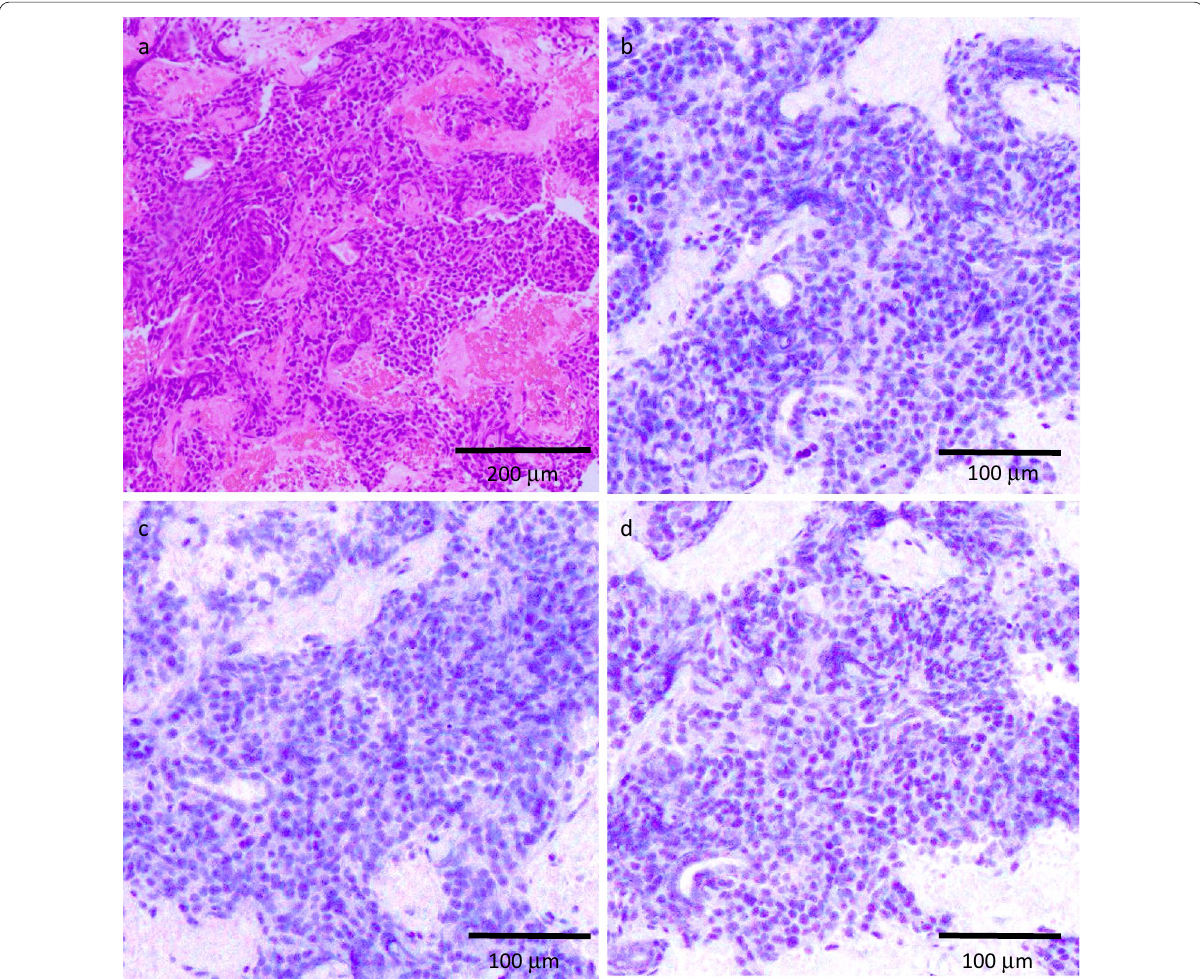
Fig. 5 Histological findings of the breast tumor (1). a The tumor cells showed solid growth and tubular structure was not observed. (hematoxylin and eosin stain). b Estrogen receptor was negative. c Progesterone receptor was negative. d HER2 was